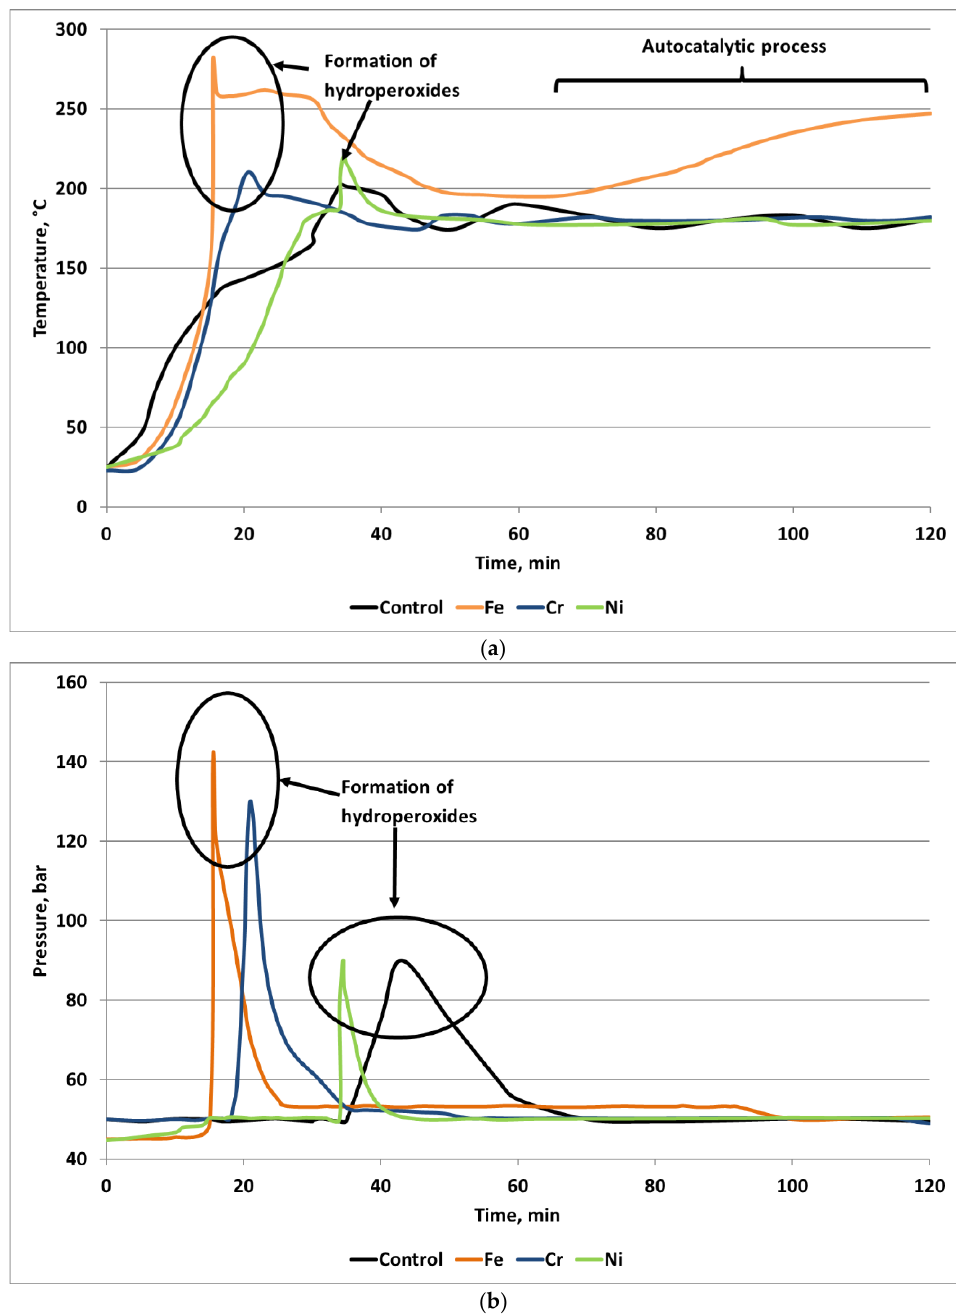
Figure 3. Temperature ( a ) and pressure ( b ) profiles during oxidation of n-hexane in the absence and the presence of Fe-, Cr-, Ni-based catalysts.